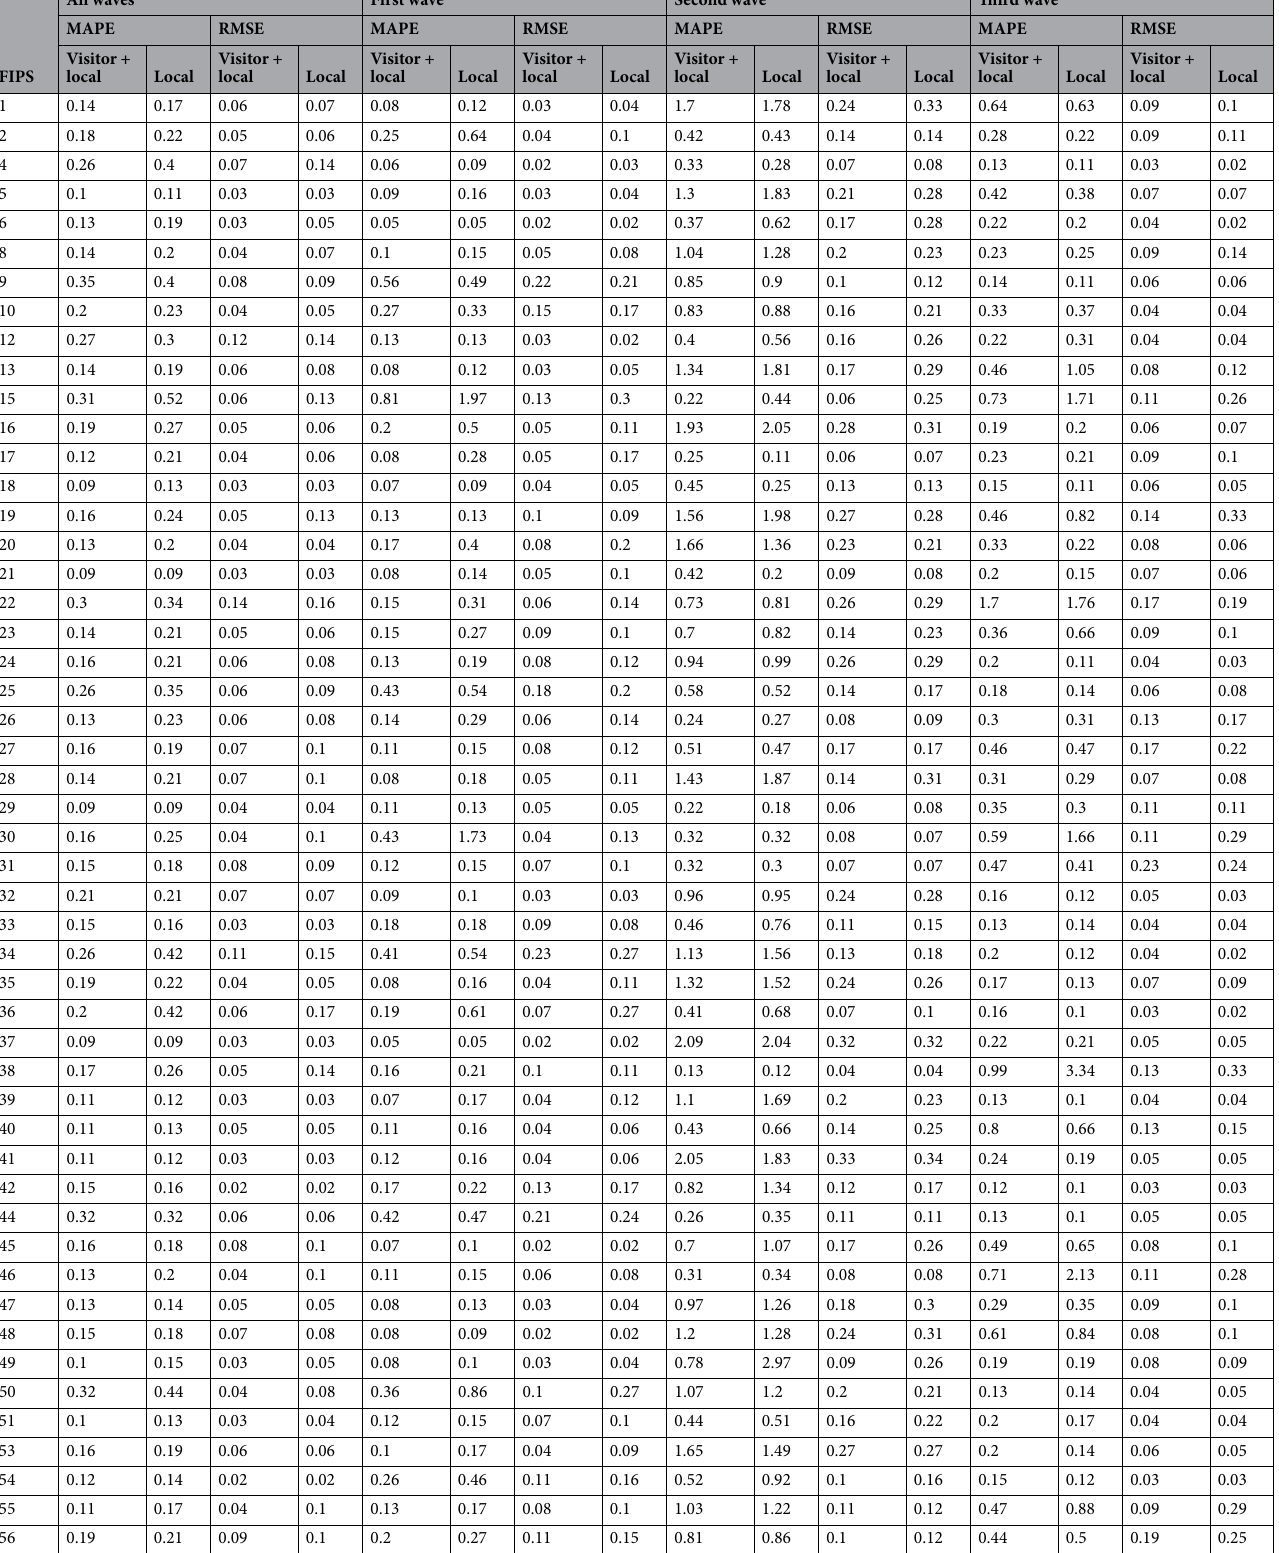
Table 6. The accuracy for each state for case forecasting using visitor and local, and just local transmission risk using